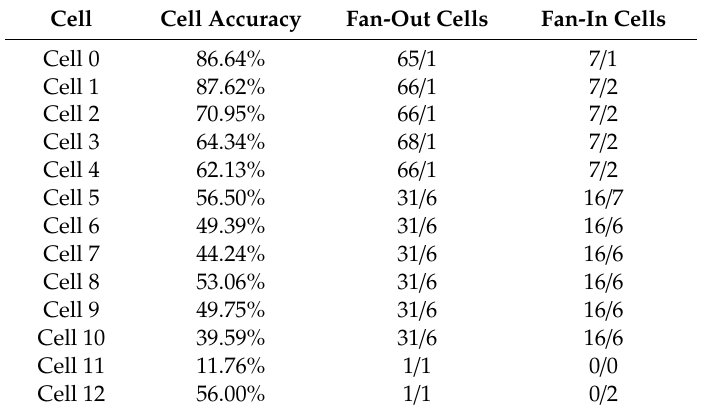
Table 8. Accuracy of scan-chain diagnosis for SA0 faults occurring in the first scan-chain cells. Cell Cell Accuracy Fan-Out Cells Fan-In Cells